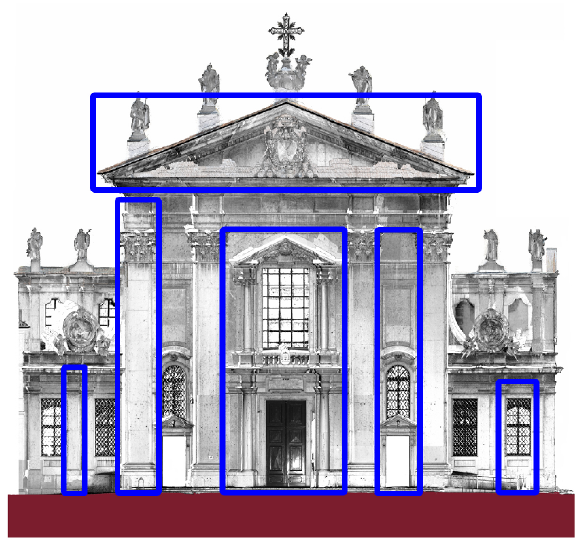
Figure 6. The six families that will be developed in Autodesk Revit, marked with blue rectangles, over an orthophoto of the fac¸ade, generated in Cyclone from the pointclouds.